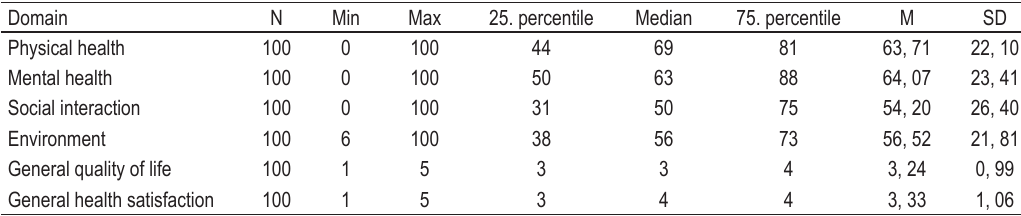
TABLE 1. Quality of live assessment of mothers Domain